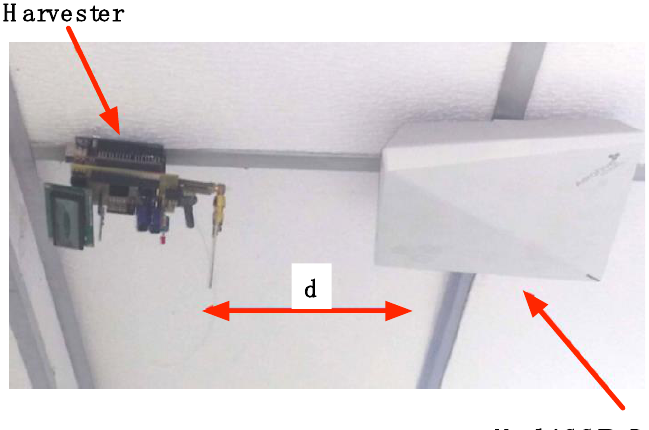
Figure 20. Test set up for the energy harvester with a multi SSID router.